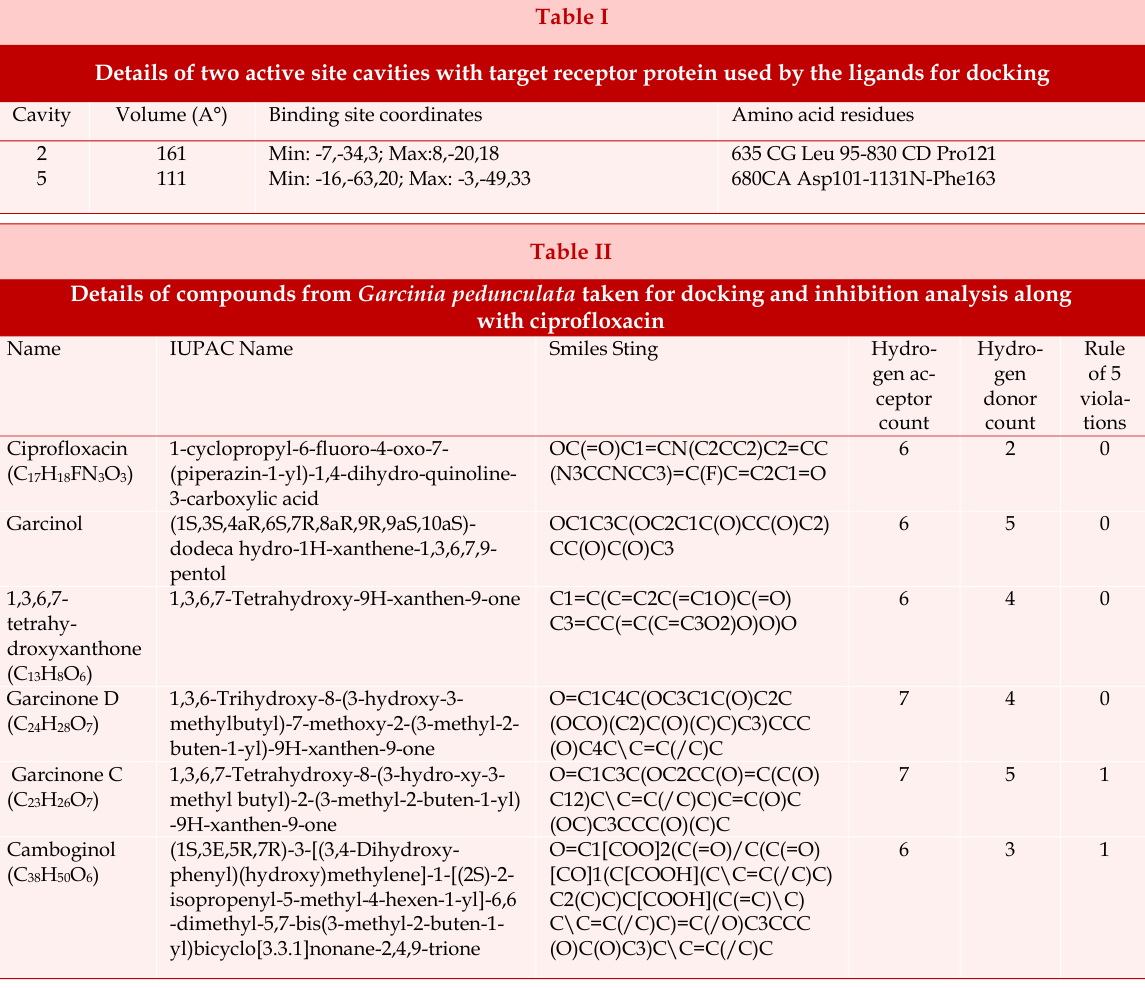
in UCSF Chimera (Pettersen et al., 2004) is given in Figure 1. Out of these, docking was seen to take place only within two active sites, cavity 2 and 5 the details of which is given in Table I. Based on the binding compatibility (kcal/mol) with the